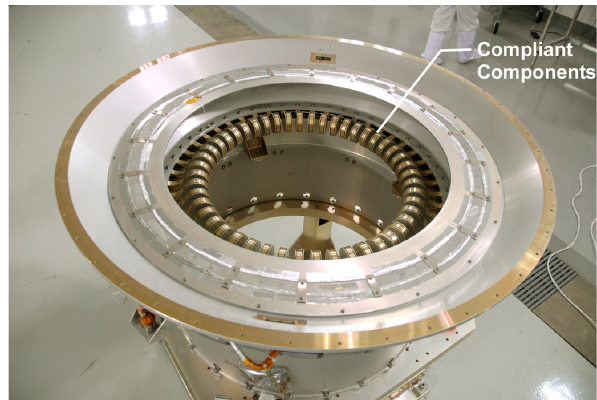
Figure 4. Example of a compliant space mechanism. SoftRide vibration isolation mechanism. Compliant segments are labeled. Courtesy of U.C. Berkeley.